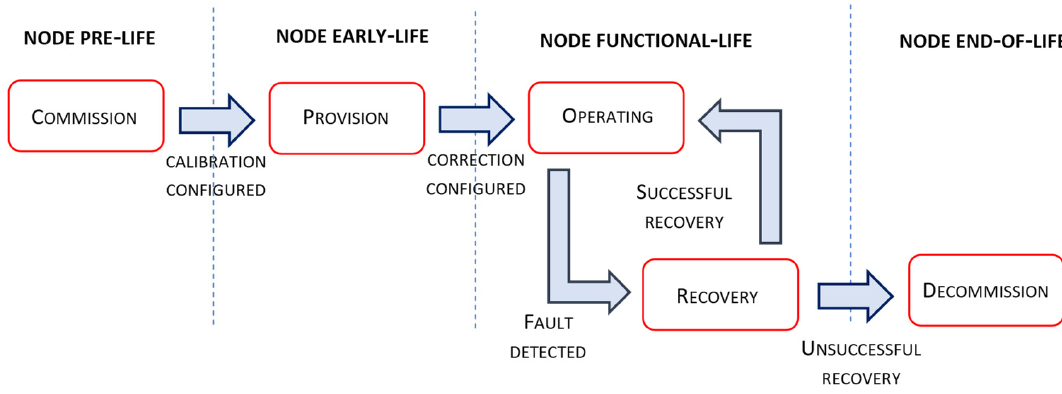
Figure 2. Tier 1 fog node management life cycle.